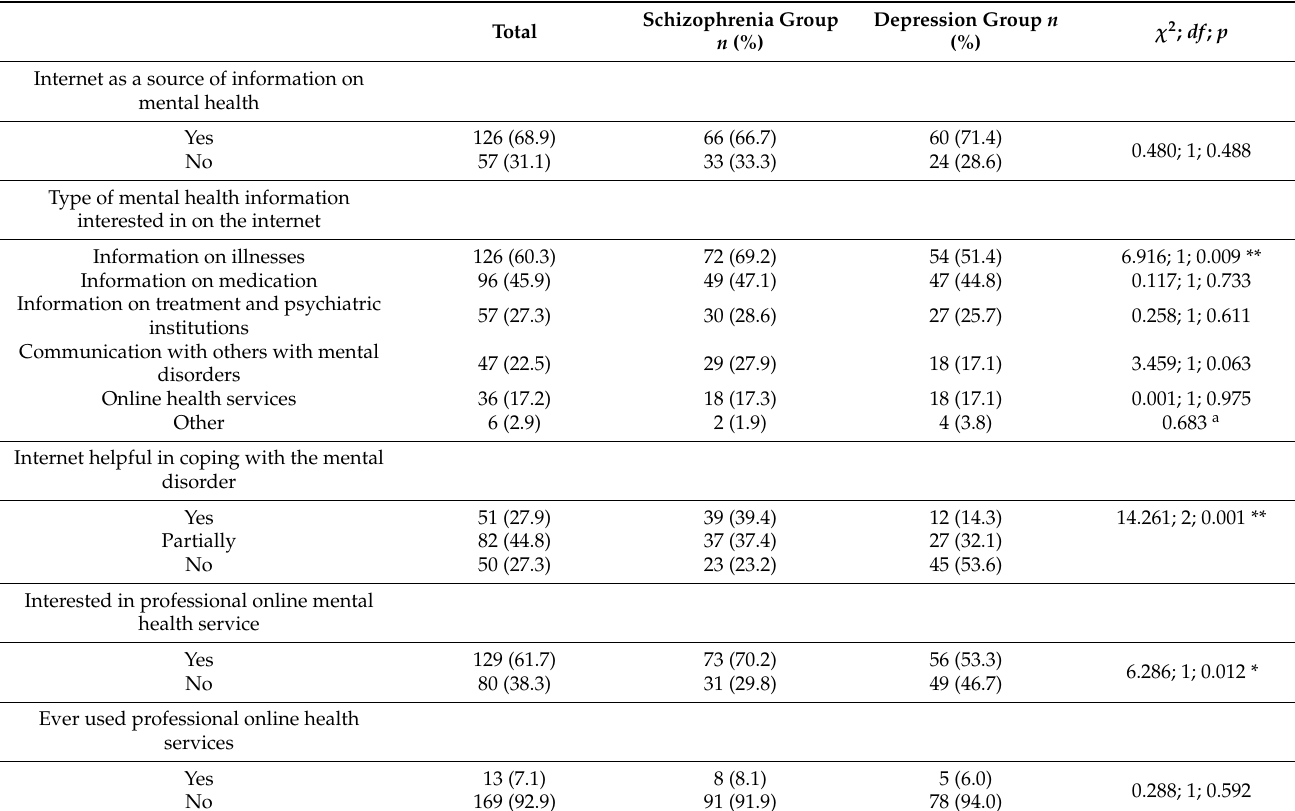
Table 8. Mental-health-related internet use and